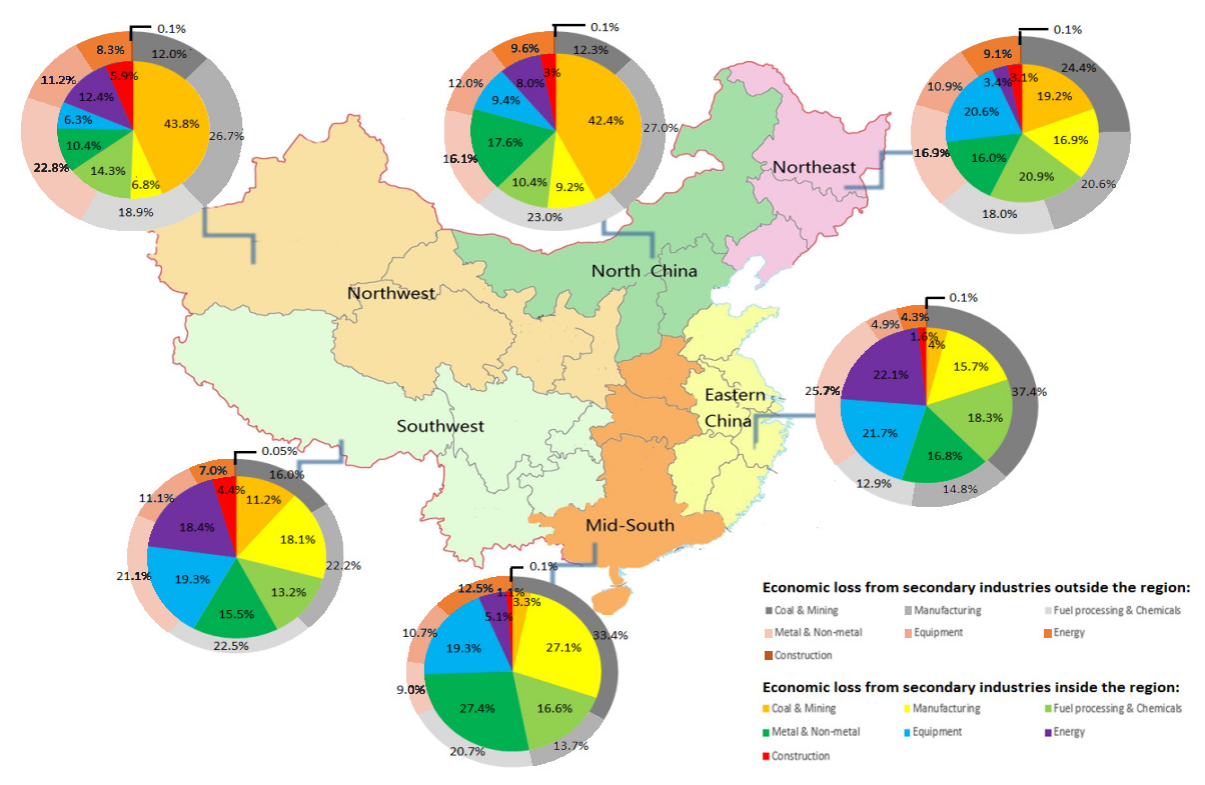
Figure 5. Economic loss from seven industries in secondary sector inside and outside the region. The inner circle shows the economic loss from secondary sector inside the region. The size of circle stands for the different proportions of inner-regional economic loss relative to total regional economic loss. Colours demonstrate economic loss from seven sectors in secondary sector inside the region. Meanwhile, the outer circle indicates the economic loss from secondary sectors outside the region. Economic loss resulting from seven sectors are shown in black and white. Percentages shown on the outer circle are the proportions of indirect loss from other regions relative to total regional indirect economic